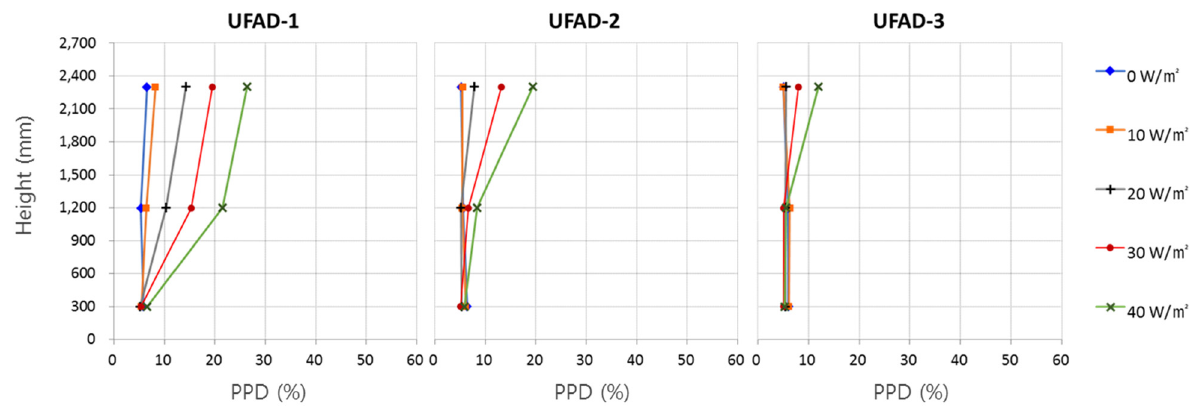
Figure 25. Vertical distribution of PPD at (X1, Y2),